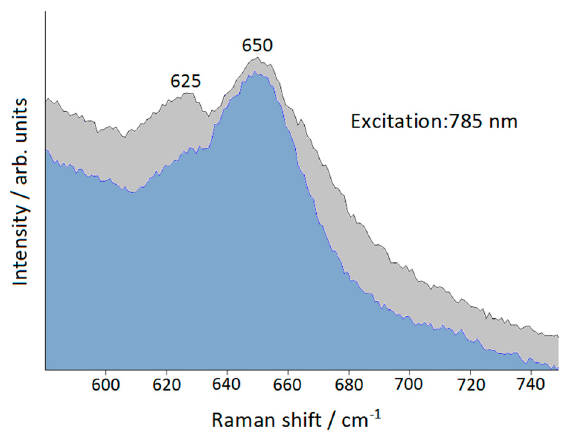
Figure 5. Micro-Raman spectra of deposited colloidal nanoparticles. The two spectra, evidenced by different colors, are representative of different points of the sample.